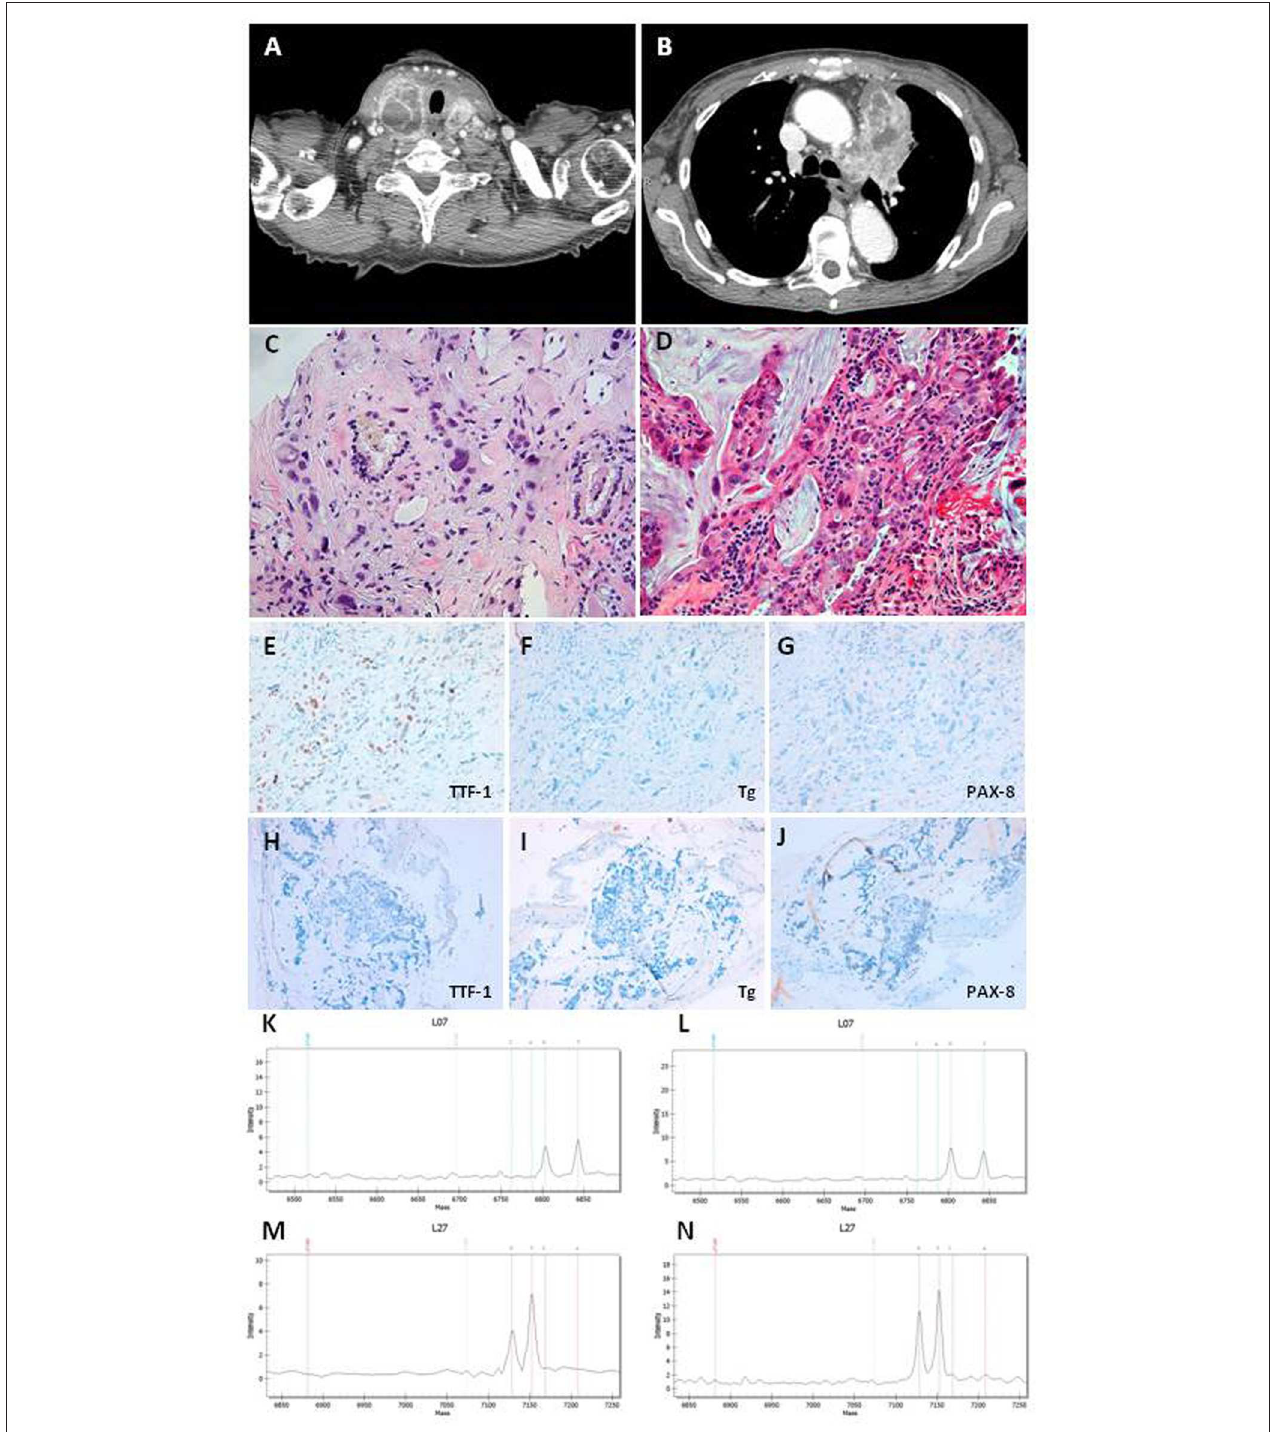
FIGURE 1 | (A) CT scan section of thyroid neoplasia. (B) CT scan section of lung neoplasia. (C) Undifferentiated carcinoma with marked nuclear atypia intermixed to thyroid follicles in thyroid Tru-cut. Magnifications: x200. (D) Adenocarcinoma with mucinous differentiation in bronchial biopsy. Magnifications: x200. (E–G) Immunohistochemistry in thyroid Tru-cut showing focal immunoreactivity for TTF-1 and absence of immunoreactivity for Thyroglobulin and PAX-8 markers. Original magnifications: x200. (H–J) Immunohistochemistry in bronchial biopsy showing absence of immunoreactivity for TTF-1, Thyroglobulin, and PAX-8 markers. Original magnifications: x200. (K,L) Mass spectrometry of thyroid neoplasia with substitution c.34G > T (p.G12C) in the codon 12 of kRAS gene. (M,N) Mass spectrometry of lung neoplasia with substitution c.34G > T (p.G12C) in the codon 12 of kRAS gene.